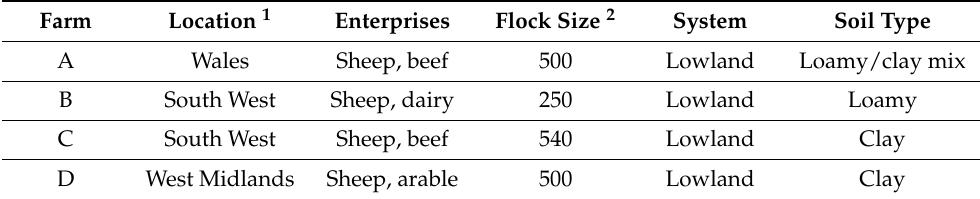
Table 1. Description of the four commercial sheep farms (A–D) selected for the